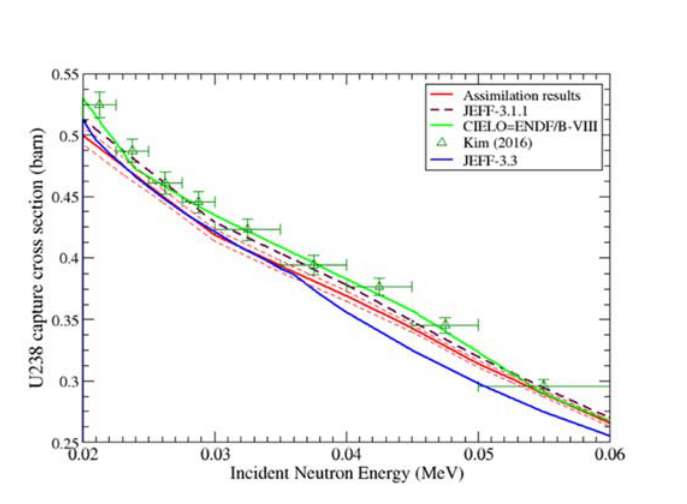
Figure 2 : Assimilation Results compared to major evaluations for 238 U capture Because Prompt Fission Neutron Spectrum (PFNS) lacks some differential measurements, variances are large. Since integral experiments available cannot distinguish between  and  (PFNS) the possibility of having compensating errors is high. Hence, a parametric study has been conducted with 235 U and 238 U PFNS fitted or not through assimilation. The magnitude of trends on 238 U capture cross sections differ on whether 235 U and 238 U PFNS is fitted or not through assimilation. In the plateau region (~1 MeV to 6 MeV), a 5-6% decrease is suggested for 238 U inelastic. This decrease trend is in agreement with recent evaluations (see suggested value compared to CIELO and JEFF-3.3 ones on Figure 3; Posterior uncertainties for assimilation results are in dotted line).